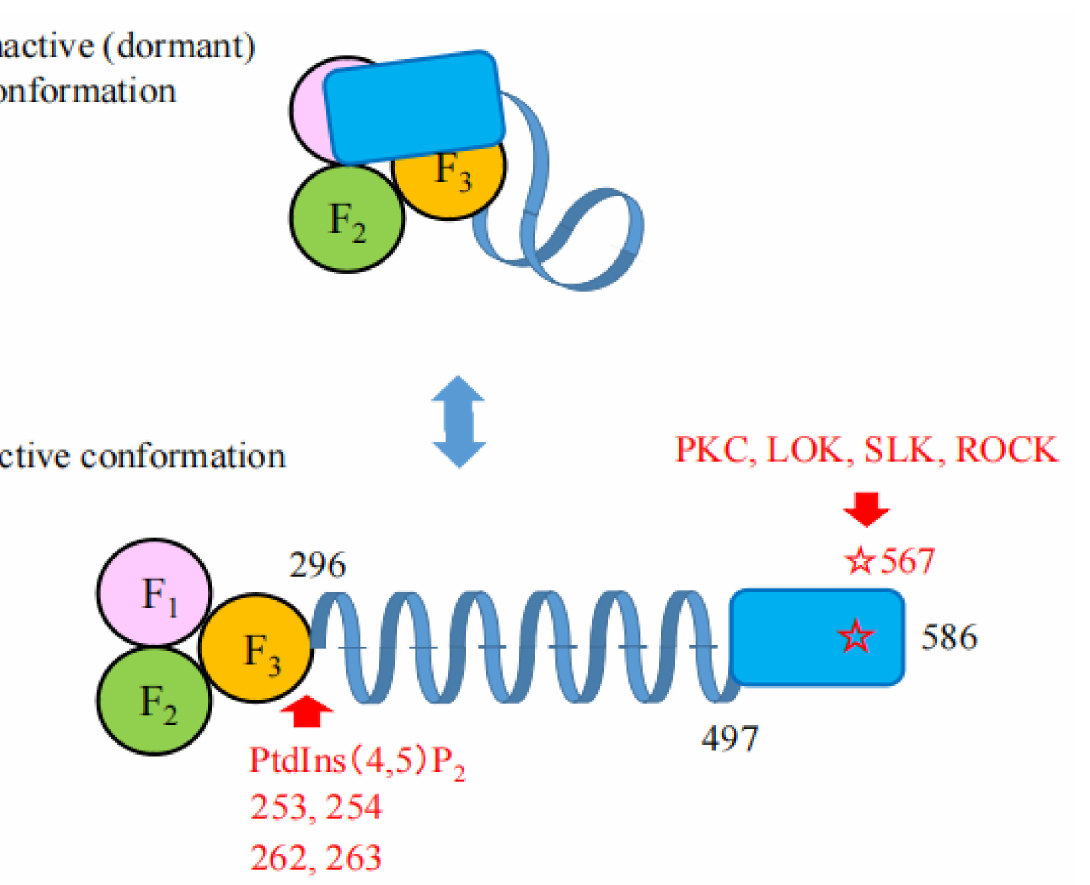
Figure 2. The function of ezrin is strictly regulated by the interaction between the N- and C-terminal domains. The upper figure represents the inactive (or dormant) form of ezrin. In this form, the N-terminal FERM domain interacts with the C-terminal domain, which makes ezrin inactive and dormant. In the lower figure, the binding of PtdIns(4,5)P 2 to the F3 lobe of the FERM domain (amino acid numbers 253, 254, 262, and 263 shown by an upward red arrow) and the subsequent phosphorylation of Thr 567 residues (shown by a red asterisk) on the C-terminal domain by PKC, LOK, SLK, or ROCK (shown by a downward red arrow) open the inactive form into the active form. The activated ezrin is recruited to the apical membrane. These processes of activation seem to be common among the ERM